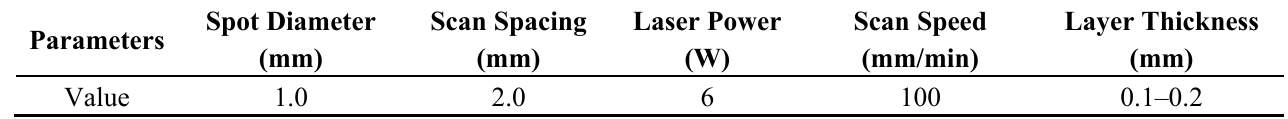
Table 1. Parameters setting for selective laser